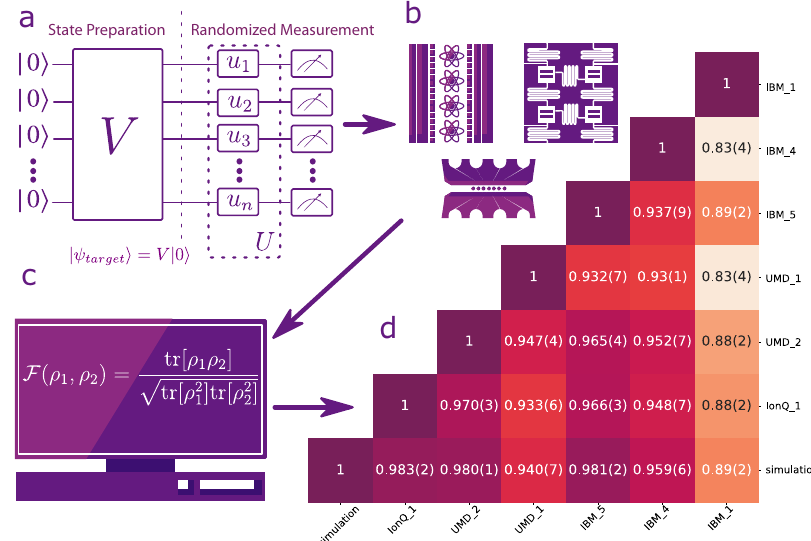
Fig. 1 | Schematic diagram of the cross-platform comparison. a Test quantum circuit, represented by unitary operator V for state preparation, with appended random rotations u i to each qubit i for measurements in a random (particular) basis. b The circuits are transpiled for different quantum platforms into their cor- responding native gates. Each of the M U circuits is repeated M S times for each platform. c The measurement results are sent to a central data repository for